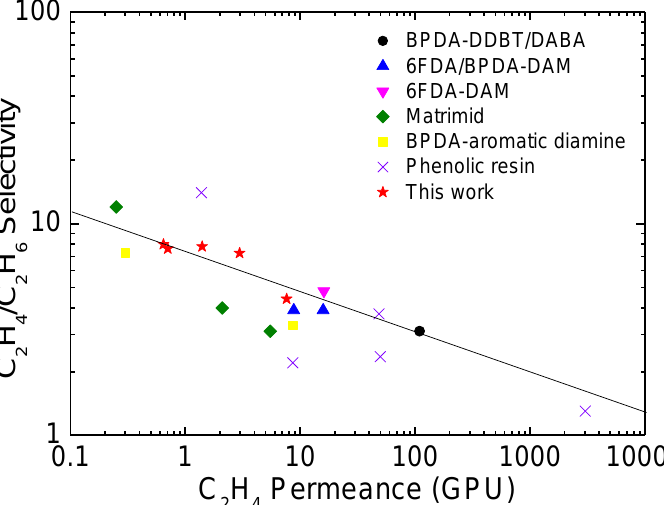
Figure 9. ( a ) XRD pattern and ( b ) pore size distribution of CMS pyrolyzed at 550, 600, and 700 °C.